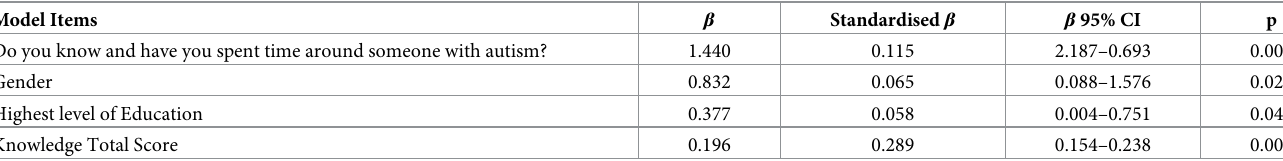
Table 8. Backward multiple linear regression statistics- knowledge total score.